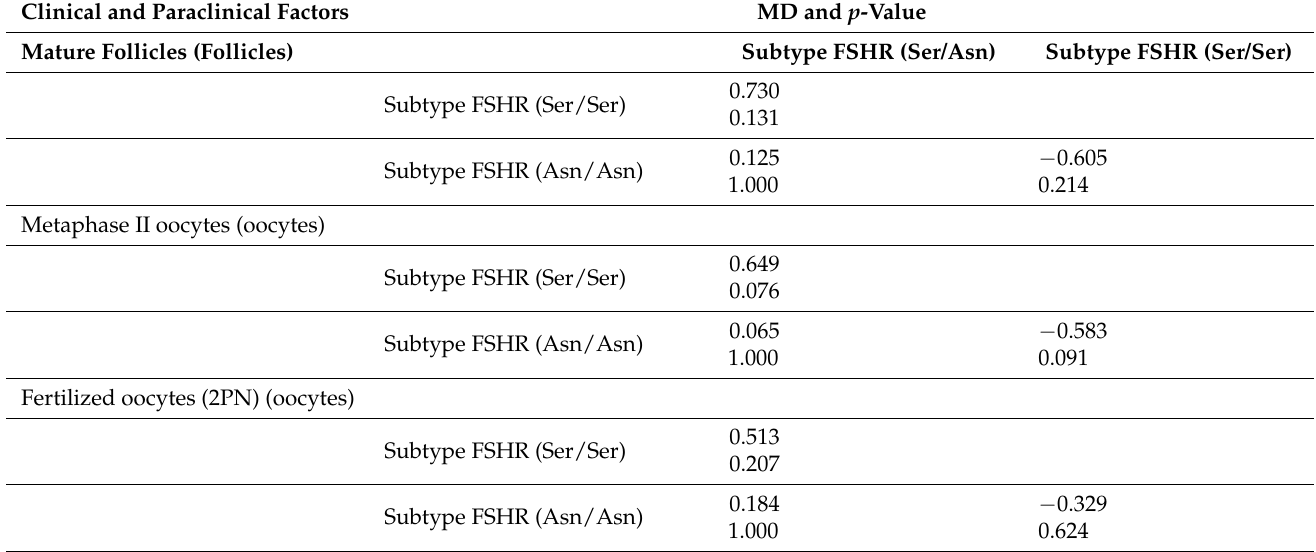
Table 6. Comparative analysis of clinical and paraclinical factors between the three FSHR subtype polymorphisms ((Ser/Ser), (Ser/Asn),